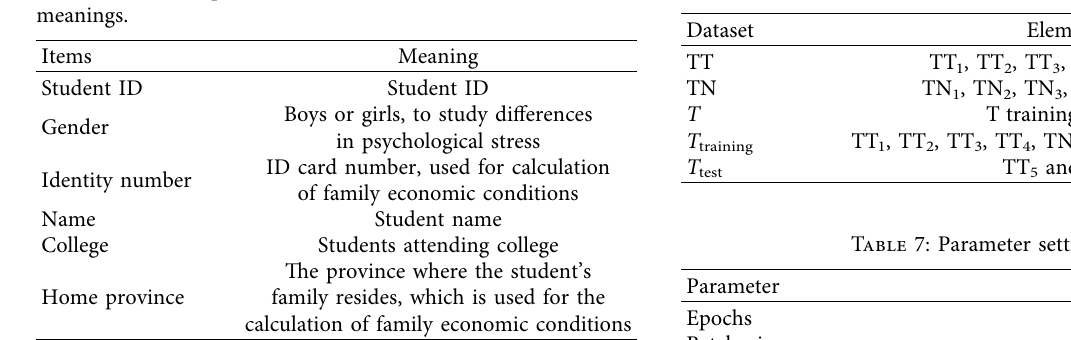
Table 6: Fivefold cross-validation dataset composition.